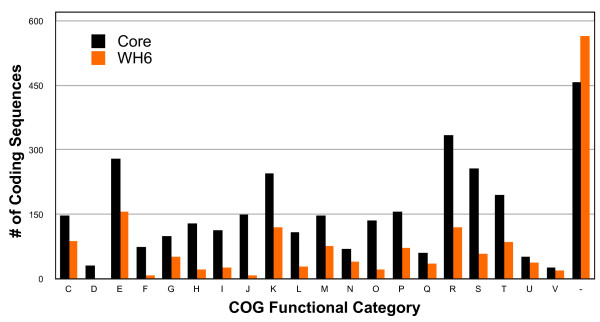
Functional categories of the 3115 core genes of P. fluorescens and 1567 unique genes of WH6. The number of genes in each category are presented above each bar; black = core; orange = WH6. Categories: C) energy production and conversion; D) cell cycle control, cell division, chromosome partitioning; E) amino acid transport and metabolism; F) nucleotide transport and metabolism; G) carbohydrate transport and metabolism; H) coenzyme transport and metabolism; I) lipid transport and metabolism; J) translation, ribosomal structure and biogenesis; K) transcription; L) replication, recombination and repair; M) cell wall/membrane/envelope biogenesis; N) cell motility; O) posttranslational modification, protein turnover, chaperones; P) inorganic ion transport and metabolism; Q) secondary metabolites biosynthesis, transport and catabolism; R) general function; S) unknown function; T) signal transduction mechanisms; U) intracellular trafficking, secretion and vesicular transport; V) defense mechanisms; -) no COG designation.